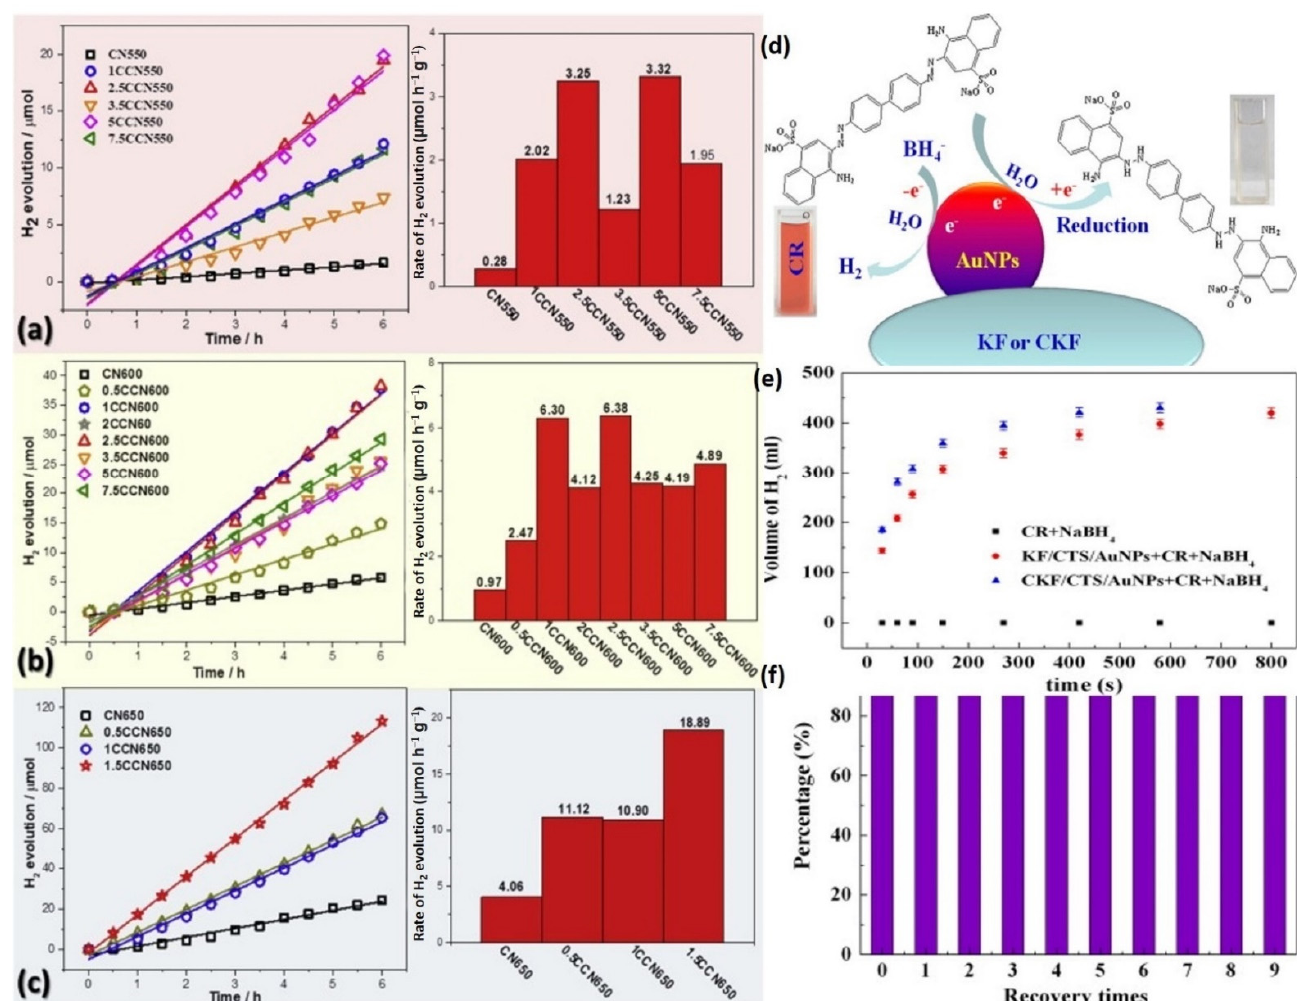
Figure 16. ( a – c ) Photocatalytic hydrogen production of g-C 3 N 4 and kapok altered g-C 3 N 4 composite created at various temperatures under visible-light exposure in 6 h and the associated Hydrogen production level. Reprinted with permission from Ref. [125]. Copyright 2019, copyright Elsevier; ( d ) process for catalytic removal of CR dye by NaBH 4 employing KF/CTS/AuNPs or CKF/CTS/AuNPs as catalysts are presented. ( e ) The proportion of hydrogen generated varies over time; ( f ) After 10 cycles, the catalytic productivity of the CKF/CTS/AuNPs nanocomposite. Reprinted with permission from Ref. [128]. Copyright 2014, copyright Elsevier.